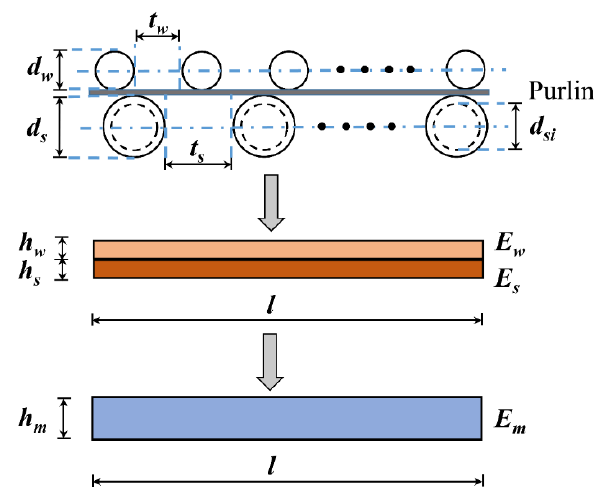
Figure 4. Equivalent of a combination of steel pipe piles and wood piles.